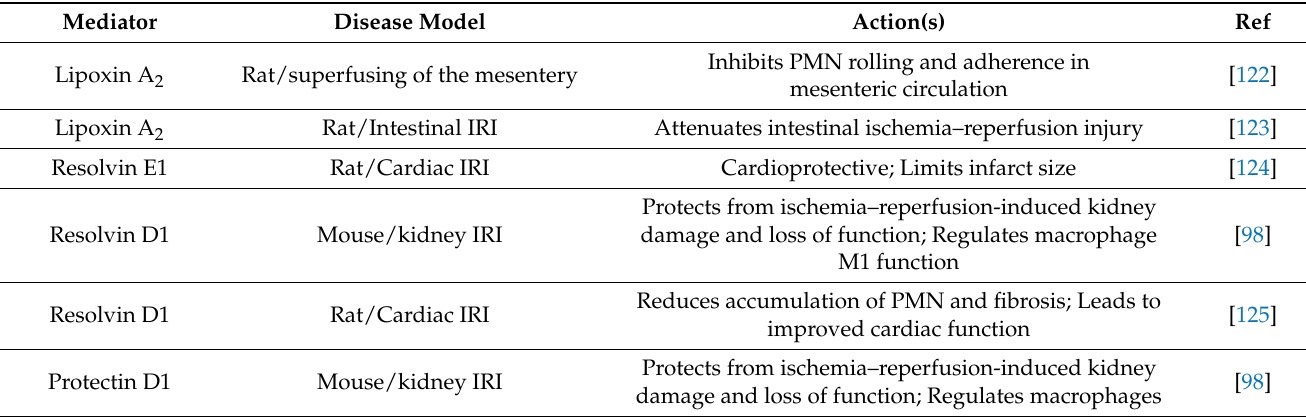
Table 2. Role of specialized pro-resolving mediators in other IRI disease